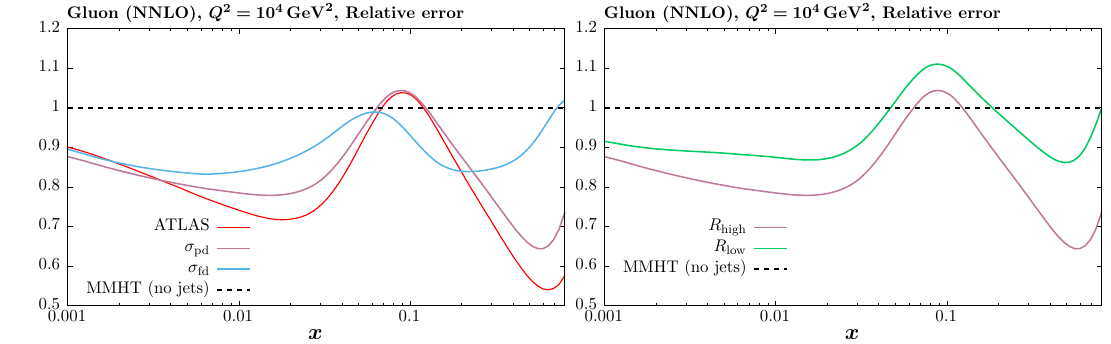
Fig. 13 The impact on the gluon PDF errors at NNLO of including the ATLAS [23] and CMS [24] 7 TeV jet data in the global fit. The ratio of the 68% C.L. errors to the baseline fit is shown for different choices of jet radius and treatment of systematic errors in the ATLAS case